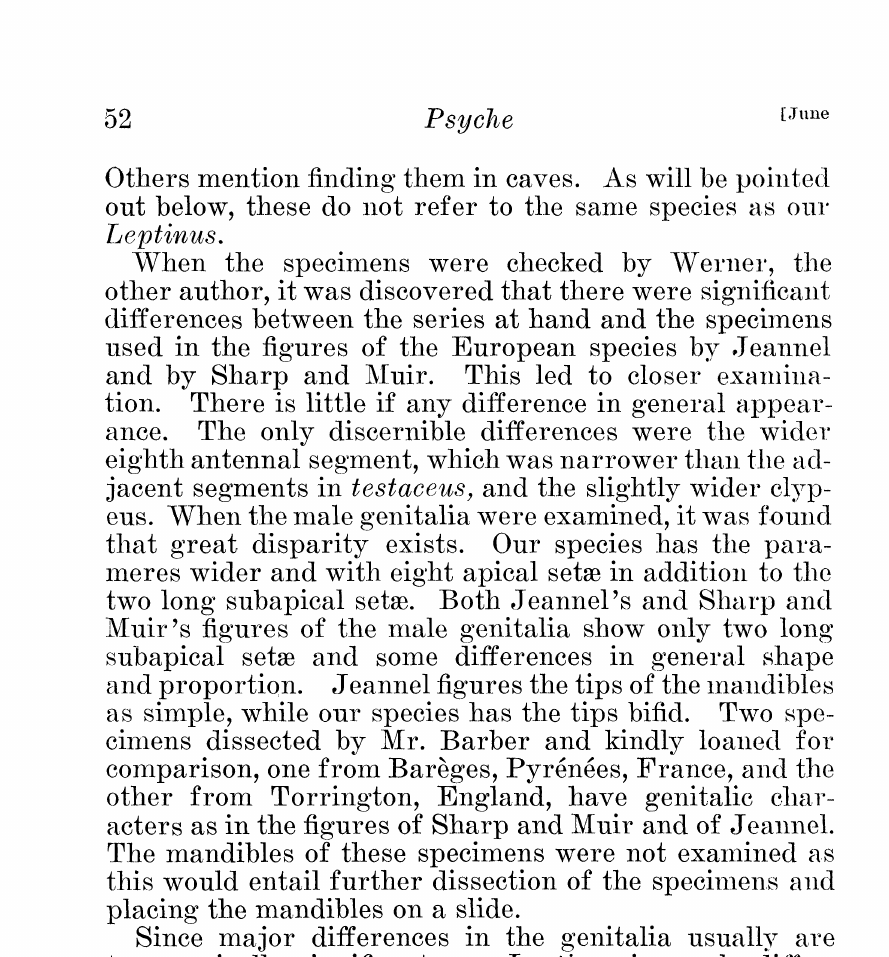
Figs. 3-5 from cleared specimens on slides, 1 & 2 from dissection of an alcoholic specimen. All deposited in M.C.Z. Fig. 1. Male genitalia, left lateral view, 238 Fig. 2. Male genitalia, dorsal view, 238 Fig. 3. Right antenna of female, dorsal view, 49. Fig. 4. Dorsal view of head of female, 49. Fig. 5. Tip of left mandible, ventral view, 382